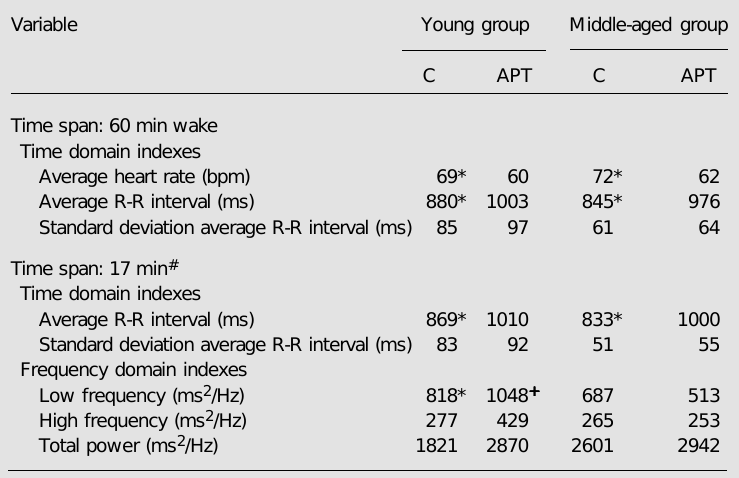
Heart rate variability was determined using time and frequency domain methods. Data are reported as medians. Young group, N = 10; middle-aged group, N = 7. # Four consecutive windows of 256 s